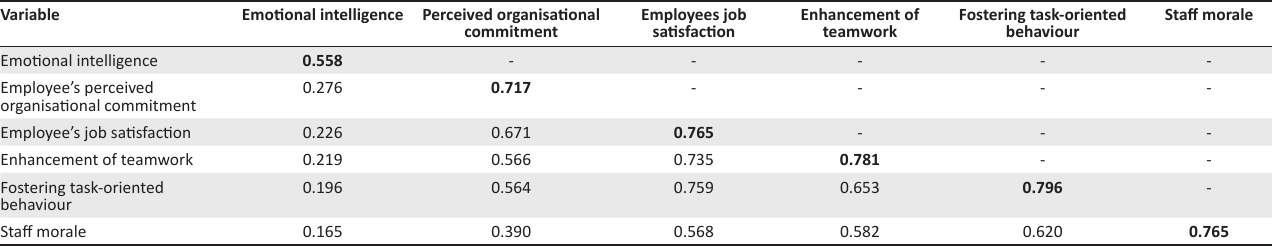
TABLE 3: Fornell and Larcker (1981) matrix to assess the discriminant validity.